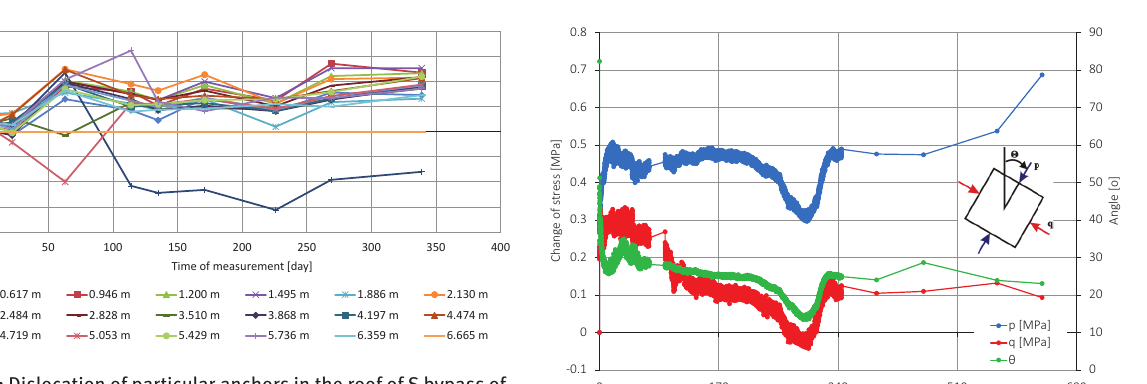
force registered in one of the three dynamometers in the